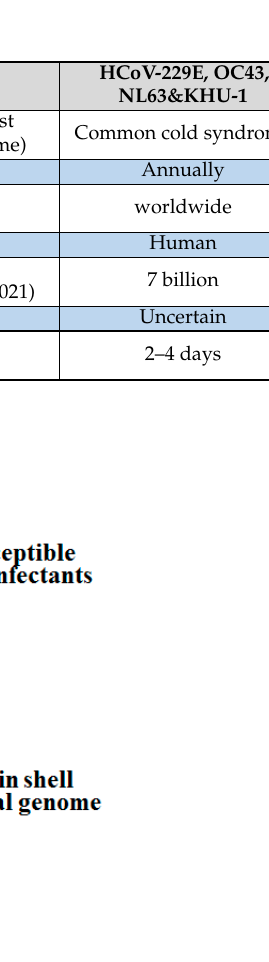
Figure 1. Schematic diagram of SARS-CoV-2. SARS-CoV-2 has a simple structure consisting of a capsid that covers genomic RNA and an envelope that covers the capsid. The envelope is pierced by hundreds of spikes composed of S protein. The S protein has been used as an antigen for all newly developed vaccines.